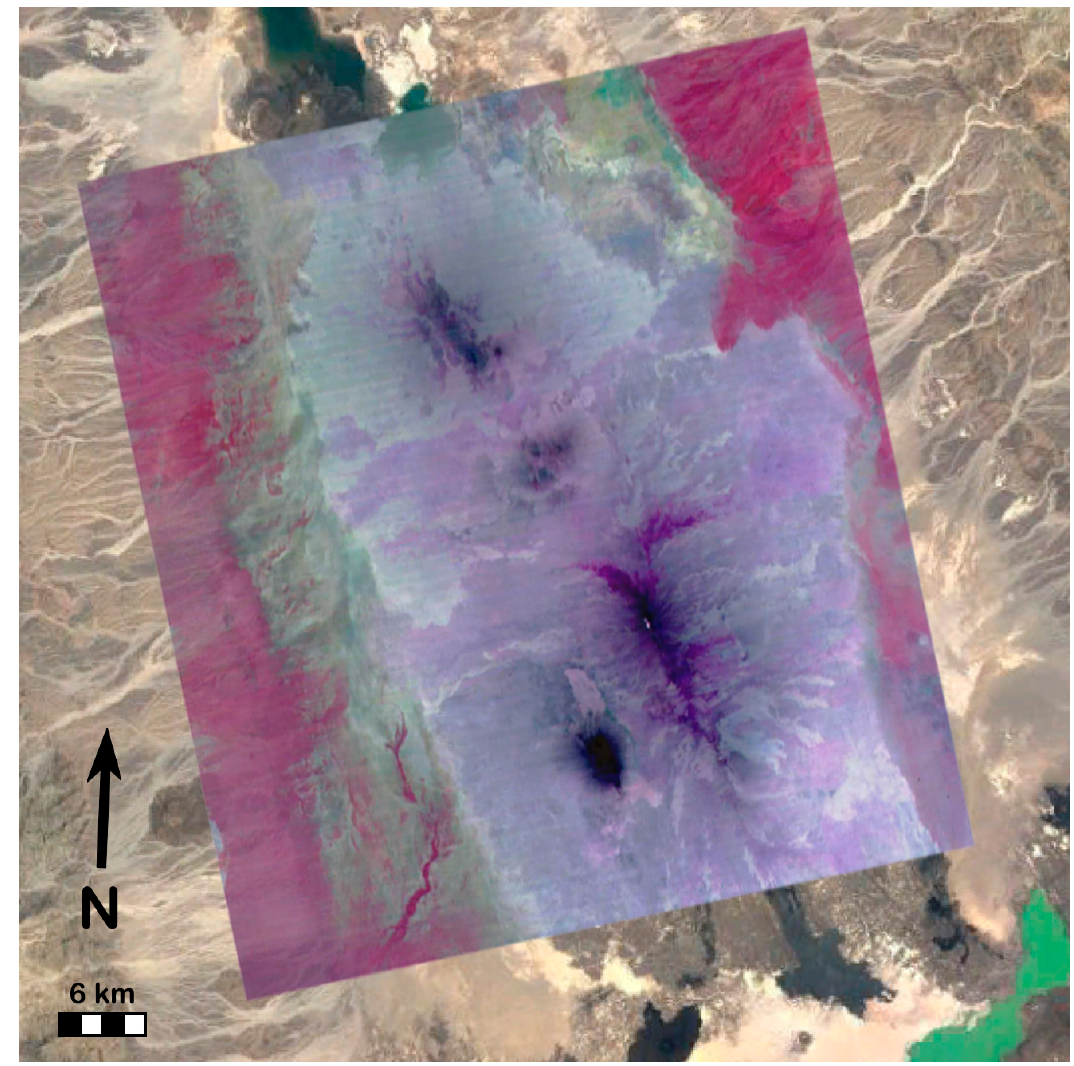
Figure 1. The first Advanced Spaceborne Thermal Emission and Reflection Radiometer (ASTER) multispectral thermal infrared (TIR) image acquired on 6 February 2000, before the start of the instrument’s science operational phase. Erta Ale volcano, Ethiopia (summit location: 13.60 ◦ N, 40.67 ◦ E), is shown using a decorrelation stretch (DCS) of the TIR bands 14, 12, 10 in red, green, and blue, respectively. Color variations are mainly caused by rock and soil compositional di ff erences, and only possible with the ASTER multispectral TIR data. The blues and purple colors are indicative of dominantly basaltic lava flows. The small cluster of white pixels in the lower central part of the image is the summit lava lake thermal anomaly. The ASTER DCS data are overlain on a visible Google Earth image for context. Image credit: NASA/METI/AIST/Japan Space Systems, and U.S./Japan ASTER Science Team.